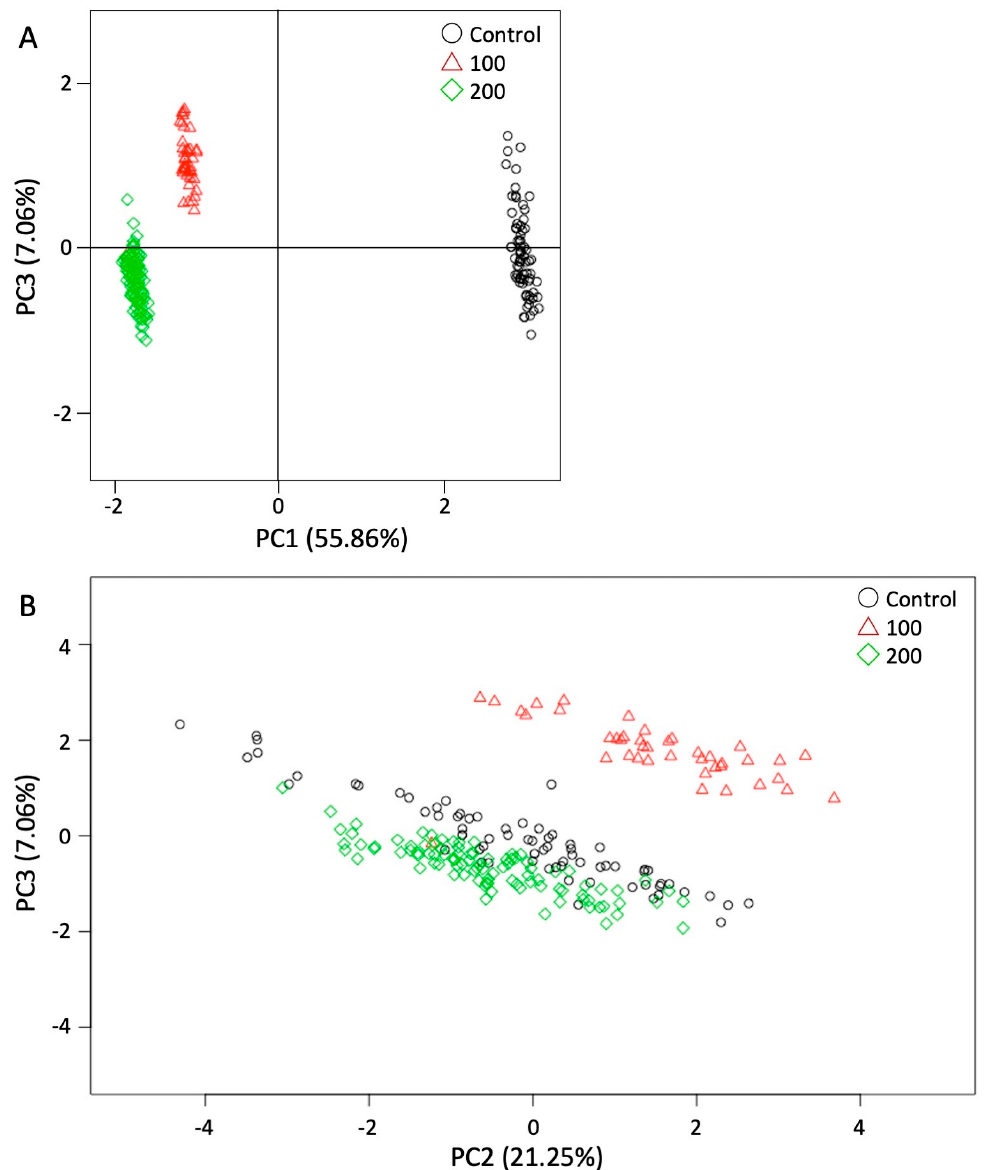
Figure 5. PCA performed using LPS concentration, fetal parameters, and gene expression. ( A ) Plot of PCA using PC1 and PC3. ( B ) Plot of PCA using PC2 and PC3. ○ : control, △ : 100 µg/kg LPS, ◇ : 200 µg/kg LPS.